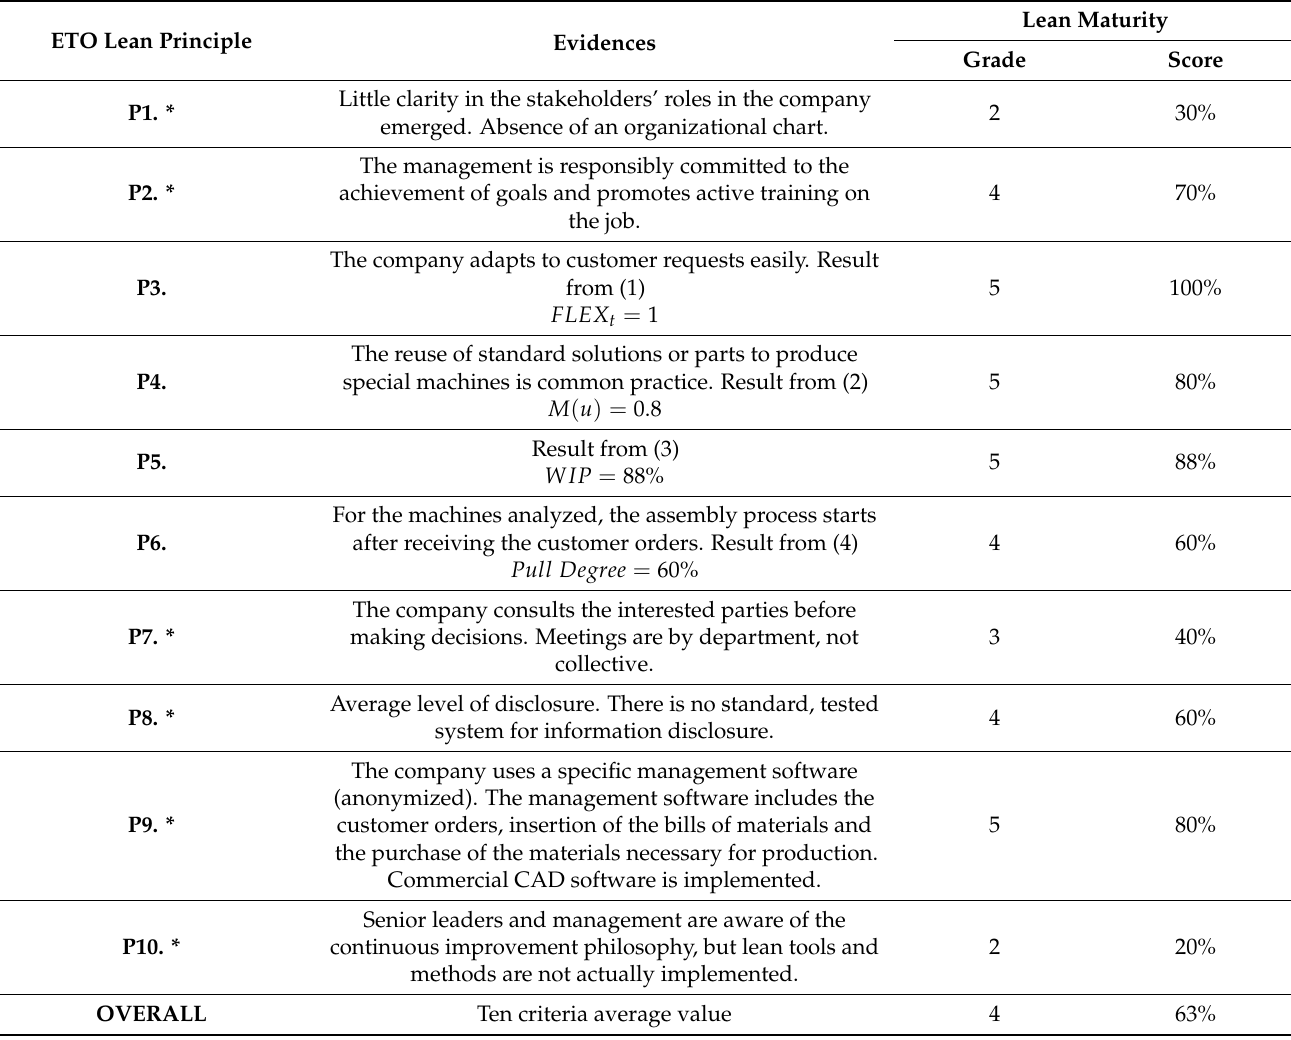
Table 3. The ten criteria, evaluated on a manufacturer of woodworking machines and lines in an ETO/MTO scenario. Maturity grades and scores are shown. In addition, all evidence for each principle has been summarized. (*) denotes principles where a mathematical formula is not defined.